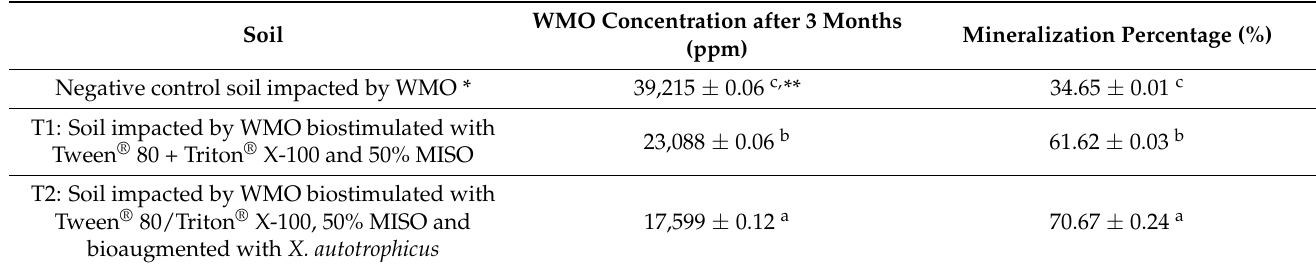
Table 2. Concentration of waste motor oil in agricultural soil after biostimulation and bioaugmenta- tion with Xanthobacter autotrophicus